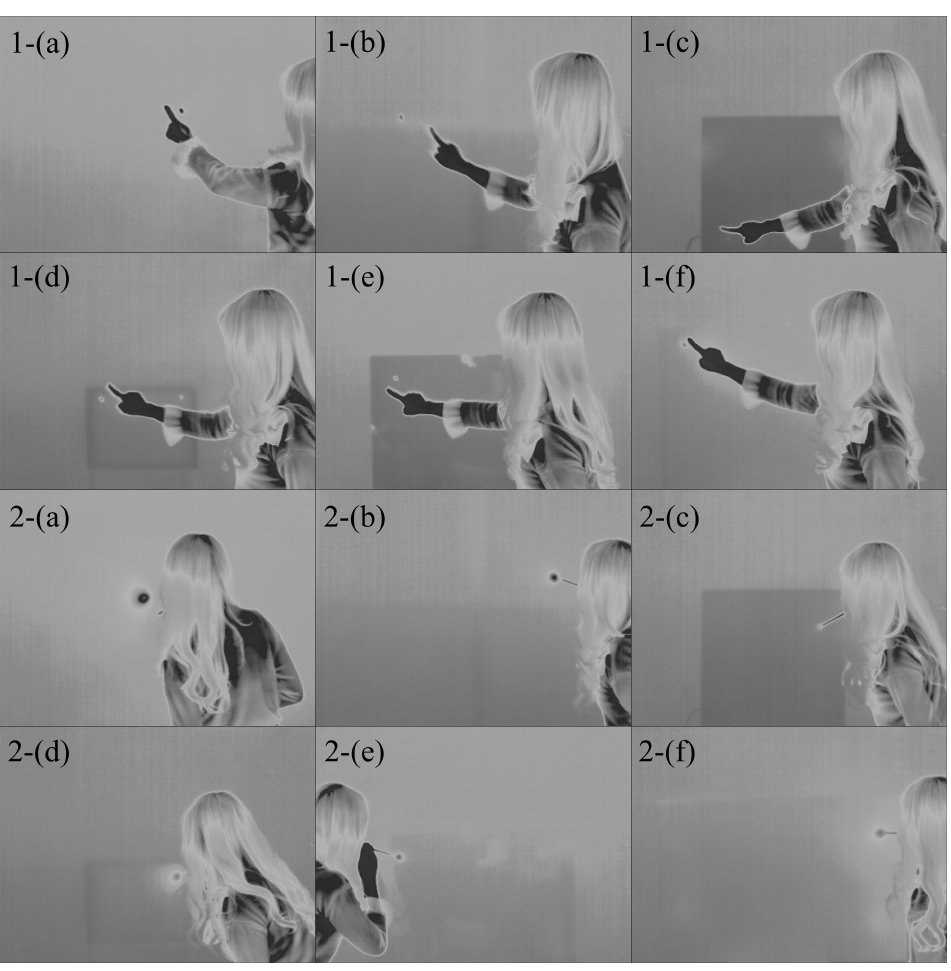
Figure 6. Scene of creation of conductive hot spot by material (thermal image). Method: 1-fingertip contact, 2-exhalation using a hollow rod. Material: ( a ) coated paper, ( b ) canvas paper for oil painting, ( c ) iron plate, ( d ) MDF in which small wood particles were united, ( e ) acrylic (thickness 2 mm), and ( f ) styrofoam board (thickness 5